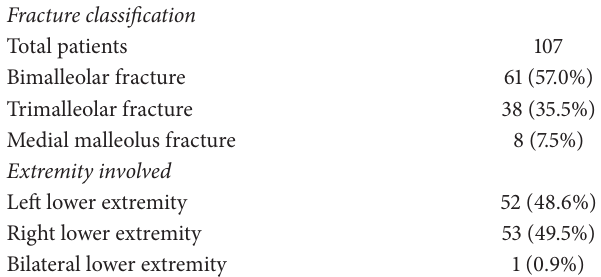
Table 3: Fracture classification and extremity